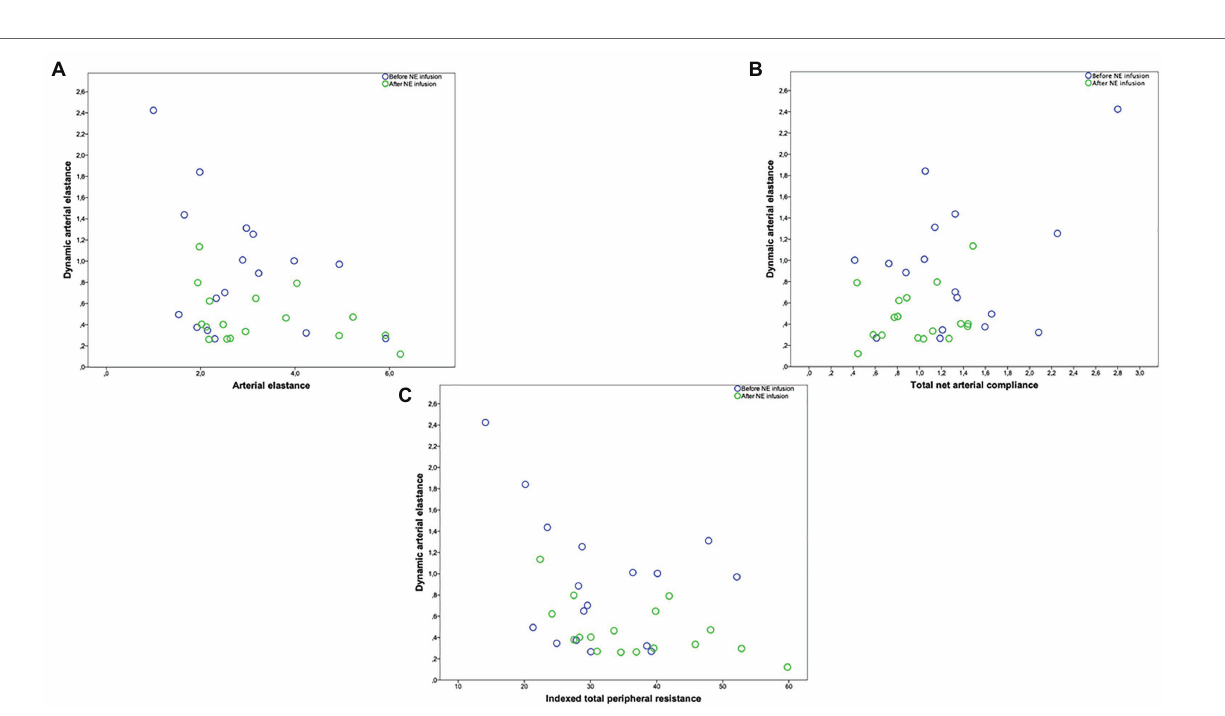
FIGURE 1 | (A) Relationship between dynamic arterial elastance and critical closing pressure (mmHg). (B) Relationship between dynamic arterial elastance and critical closing pressure minus mean systemic filling pressure (mmHg). (C) Relationship between dynamic arterial elastance and indexed systemic arterial resistance (mmHg ml −1 ·m −2 ). Circle color refers to before (blue circle)/after norepinephrine (NE) infusion (green circle).